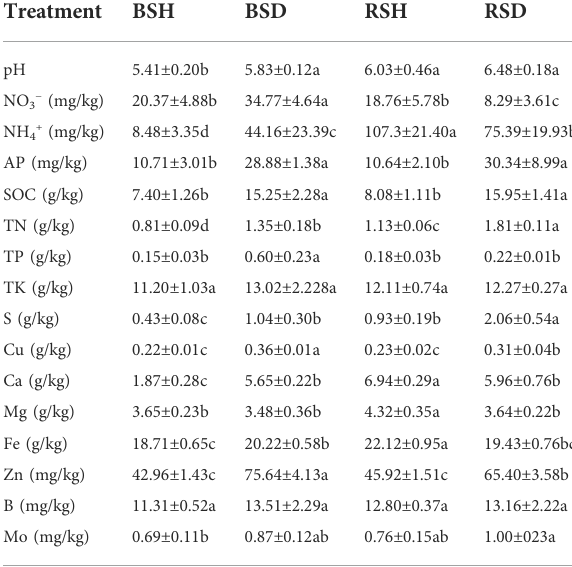
TABLE 1 Physicochemical properties of the bulk soil of healthy plants, the bulk soil of the diseased plants, the rhizosphere soil of the diseased plants and the rhizosphere soil of healthy plants. BSH, the bulk soil of healthy plants. BSD, the bulk soil of the diseased plants. RSH, the rhizosphere soil of healthy plants. RSD, different letters show signi fi cant difference among treatments. Values are means ± SEs (Duncan test, p < 0.05, n = 5). The letters in the table represent different signi fi cances (a, b, c). AP = available phosphorus, SOC = soil organic carbon, TN = total nitrogen, TP = total phosphorus, TK = total potassium, S = total sulfur, Cu = total copper, Ca = total calcium, Mg=total magnesium, Fe = total iron, Zn = total zinc, B = total boron, Mo = total